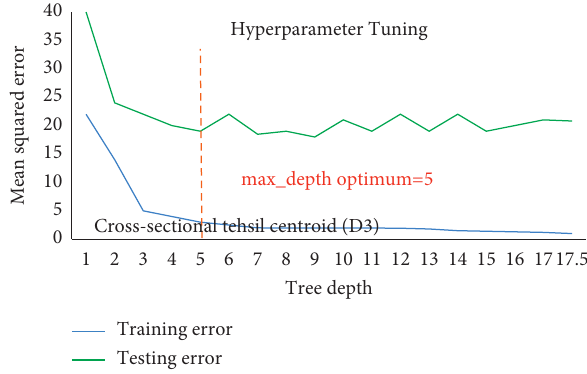
Figure 11: Hyperparametric tuning of DTR for